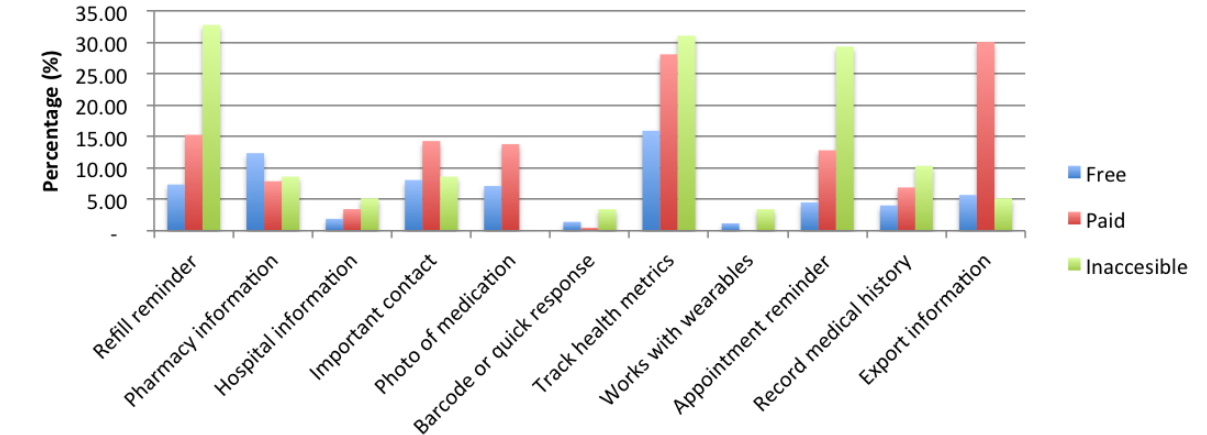
Figure 9. Chart comparing user features across payment